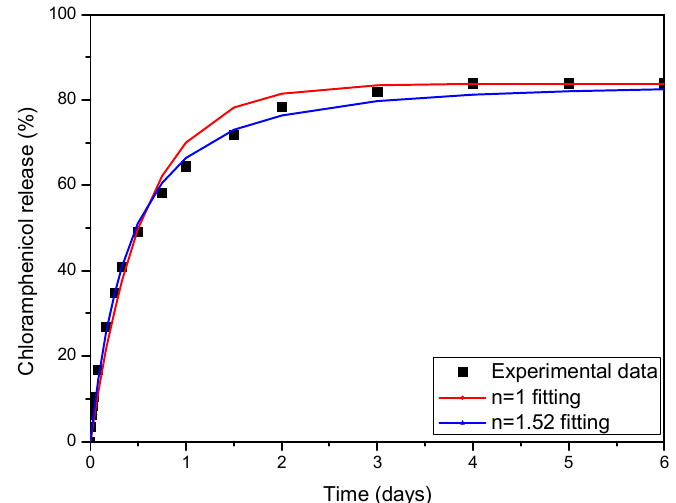
Figure 12. Comparison of experimental neat CHL release data to fitting curves for n = 1 and n = 1.52.